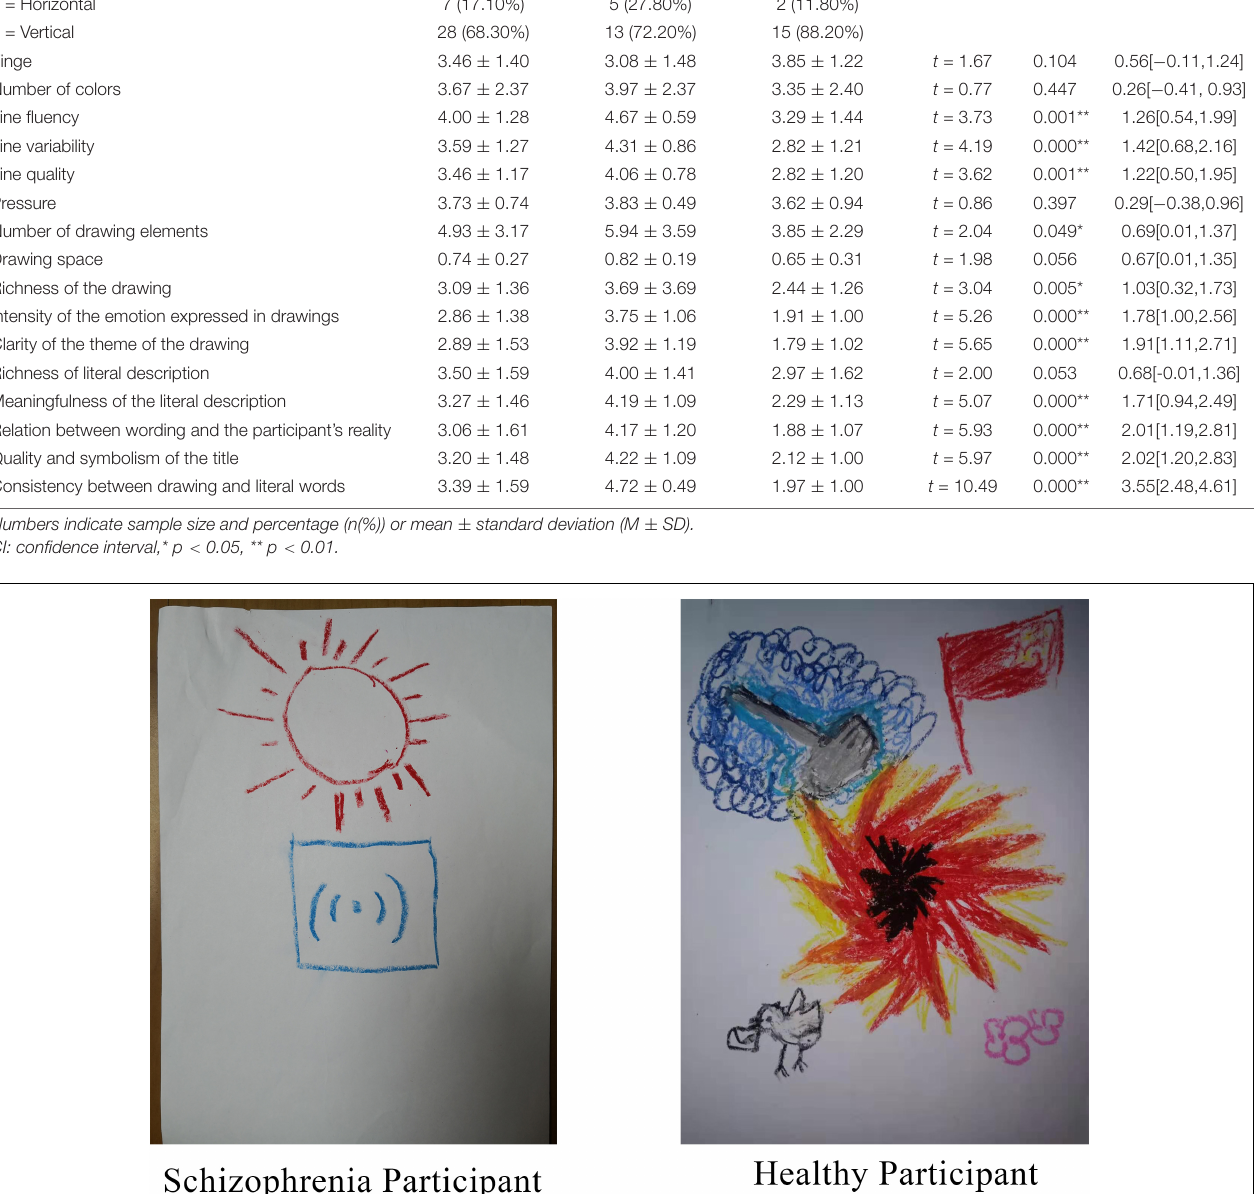
drawing, the intensity of the emotion expressed in drawings, and the clarity of the theme of the drawing. Significant group differences in the wording to describe the drawing were evident in the richness of the literal description, its meaningfulness, the relation between wording and the participant’s reality, the quality and symbolism of the title, and the